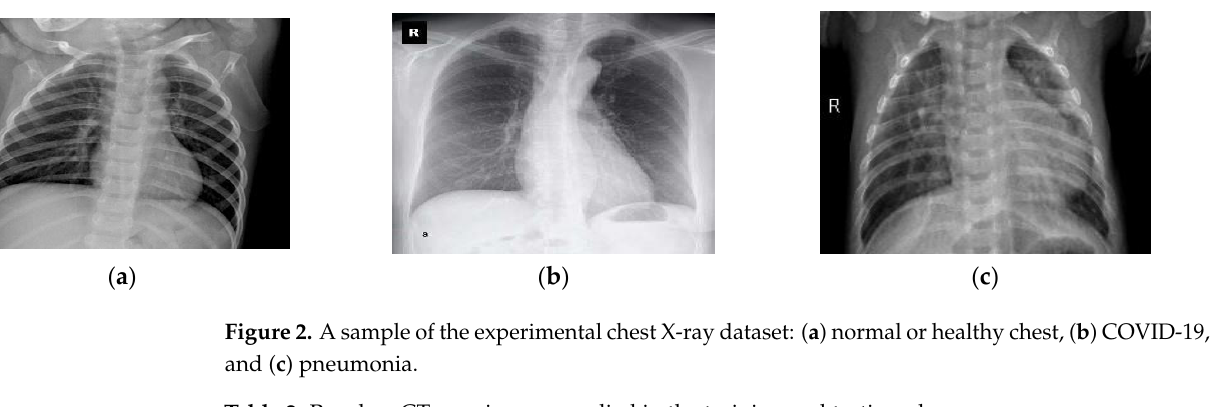
Figure 1. A sample of the experimental CT scan dataset: ( a ) normal or non-COVID-19, ( b ) COVID-19, and ( c ) community-acquired pneumonia (CAP).